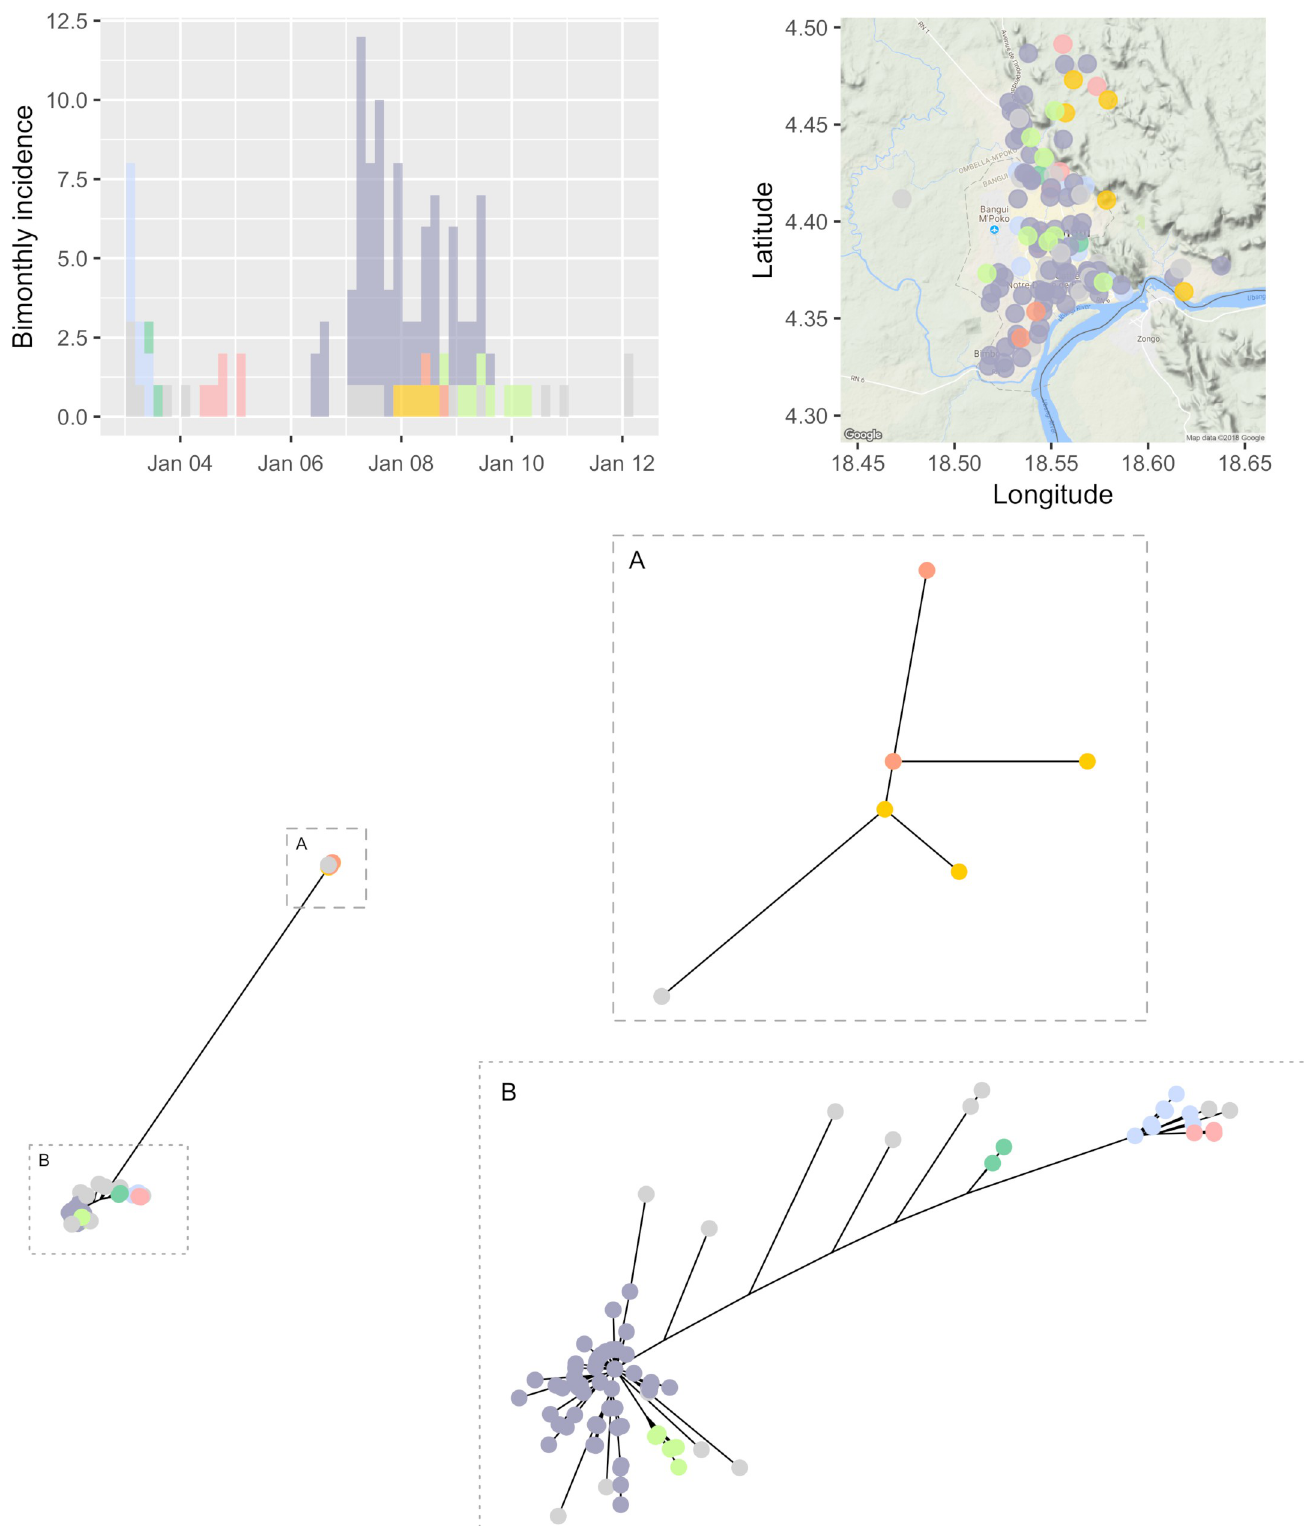
Fig 2. Visualization of the clusters of cases of rabies. The top left panel shows the incidence of reported cases of rabies over time, by date of report; cases identified as belonging to the same outbreak cluster (using all distances) are shown in the same colour (grey indicates singletons). The top right panel shows the geographic